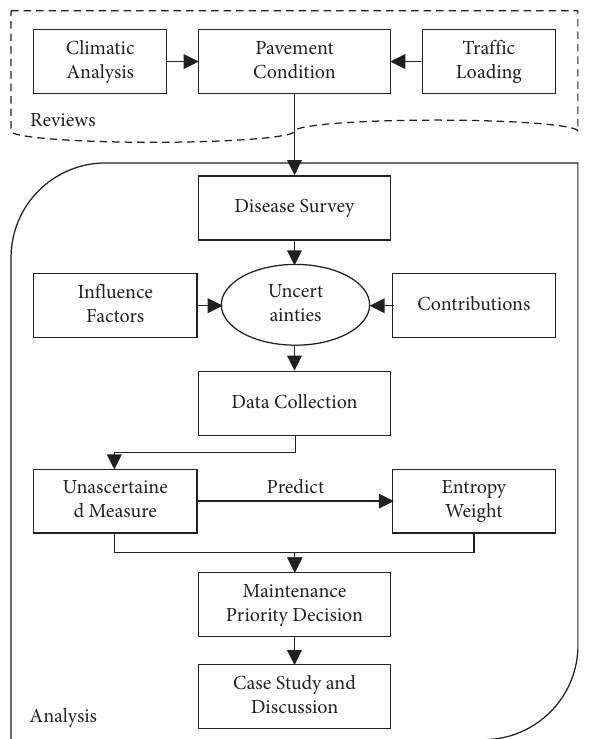
Figure 1: Flow diagram of study